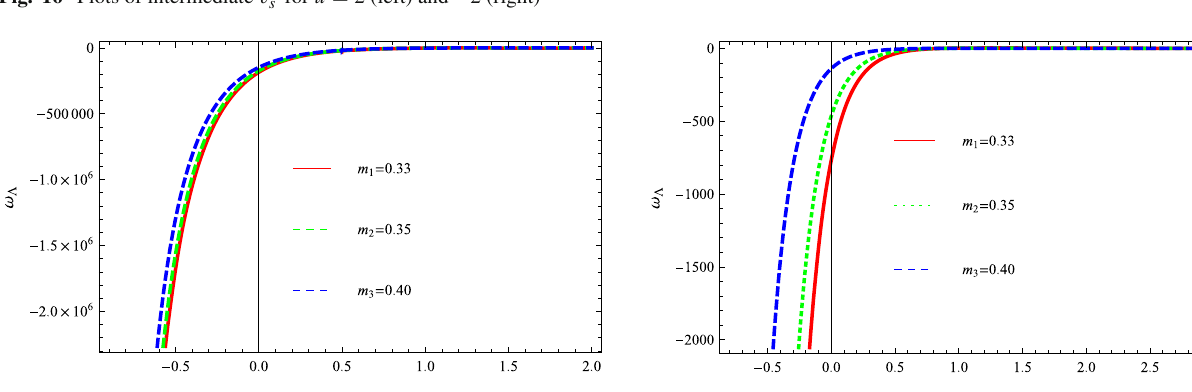
Fig. 16 Plots of intermediate v 2 s for u = 2 (left) and − 2 (right)